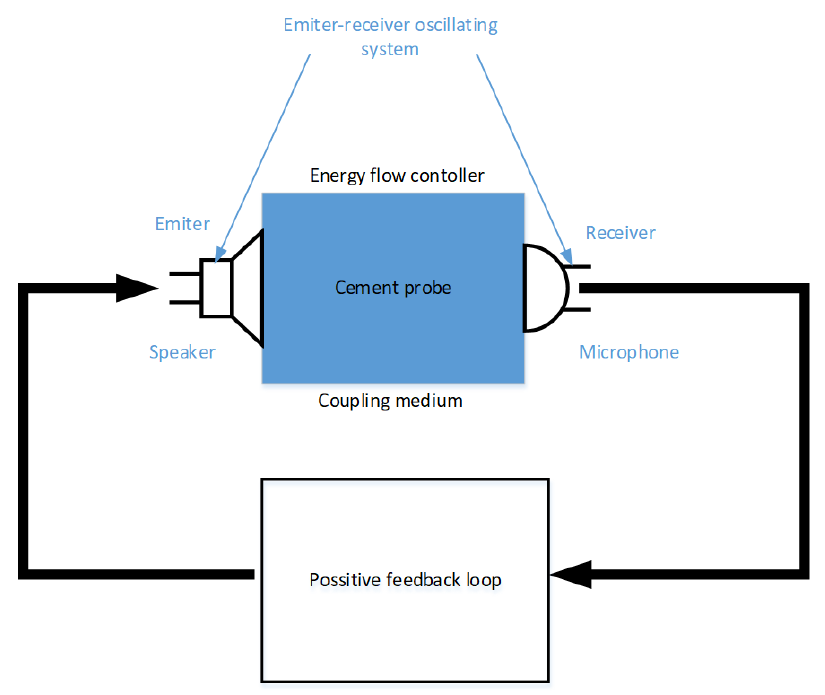
Figure 3. Test sample as a regulator of energy inflow to the SAS system.